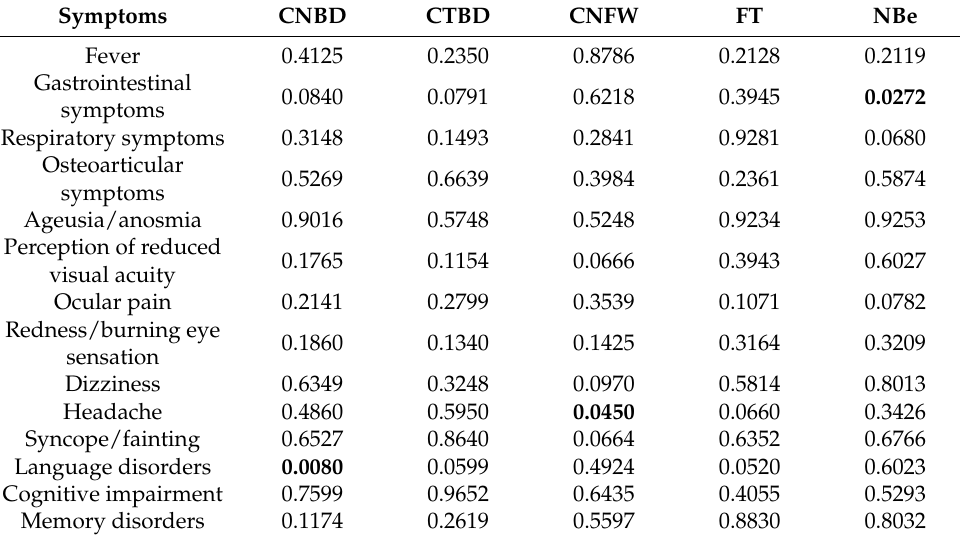
Table 5. Relationship between CCM corneal data and symptoms ( p -values from univariate